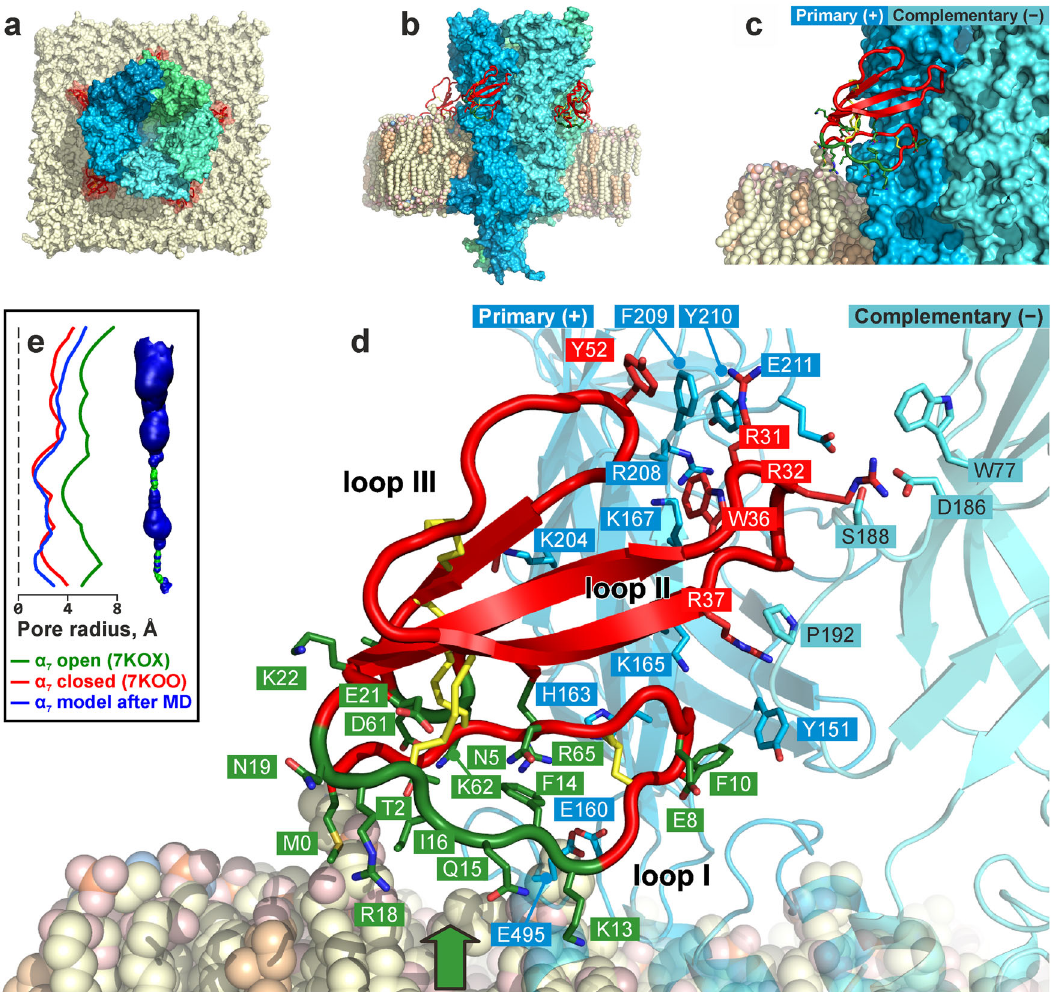
Fig. 4 Structure of α 7-nAChR/WTX complex in membrane environment. a General view of the complex from the top. nAChR subunits are individually colored in a blue-green spectrum; fi ve WTX molecules at the interfaces of two adjacent receptor ’ s subunits are shown by red. b Side view of the complex. Carbon atoms of the membrane lipids are colored as follows: POPC and POPE, pale yellow; cholesterol, pale orange. Other lipid atoms: phosphorus, orange; oxygen, red; nitrogen, blue. Lipids of the proximal part of the membrane are removed for clarity. Membrane-interacting residues of WTX are colored by forest green. c Zoomed-in picture of WTX interacting by the loops II and III with α 7-nAChR and by loop I, head-1, and N - and C -termini with the membrane. d Snapshot of WTX-nAChR and WTX-membrane interactions. α 7-nAChR primary ( + ) and complementary ( − ) subunits are shown as blue and cyan cartoon, respectively; WTX residues that interact with receptor (red background) or membrane (green background) are shown. Details of the WTX membrane interactions are given in Fig. 5 (from the point of view depicted by green arrow). e Pore pro fi le of the α 7-nAChR channel for the given MD snapshot. Blue volume corresponds to water-permeable cavity; green — to the impermeable (e.g., closed pore). Graphs show pore radius pro fi les: open pore in α 7-nAChR with epibatidine and PNU-120596 (PDB ID: 7KOX 16 ) — green; closed pore in α 7-nAChR with α -Bgtx (PDB ID: 7KOO 16 ) — red; and the pore in our model α 7-nAChR/WTX —